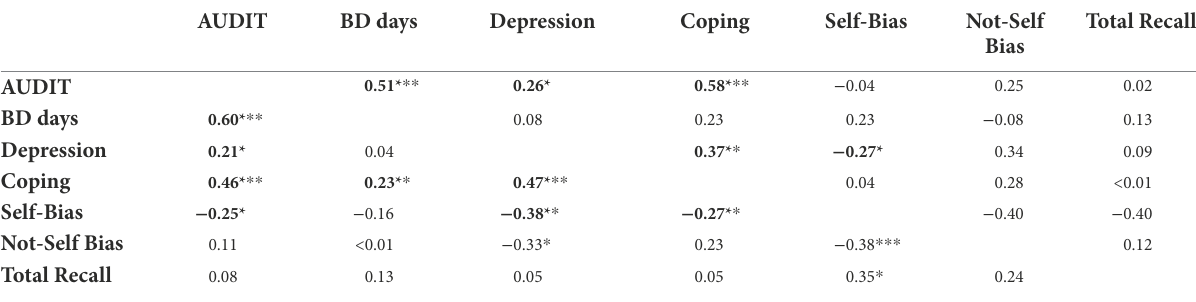
TABLE 3 Correlation matrix among female (below diagonal) and male (above) student alcohol, clinical, and memory variables of interest in Study